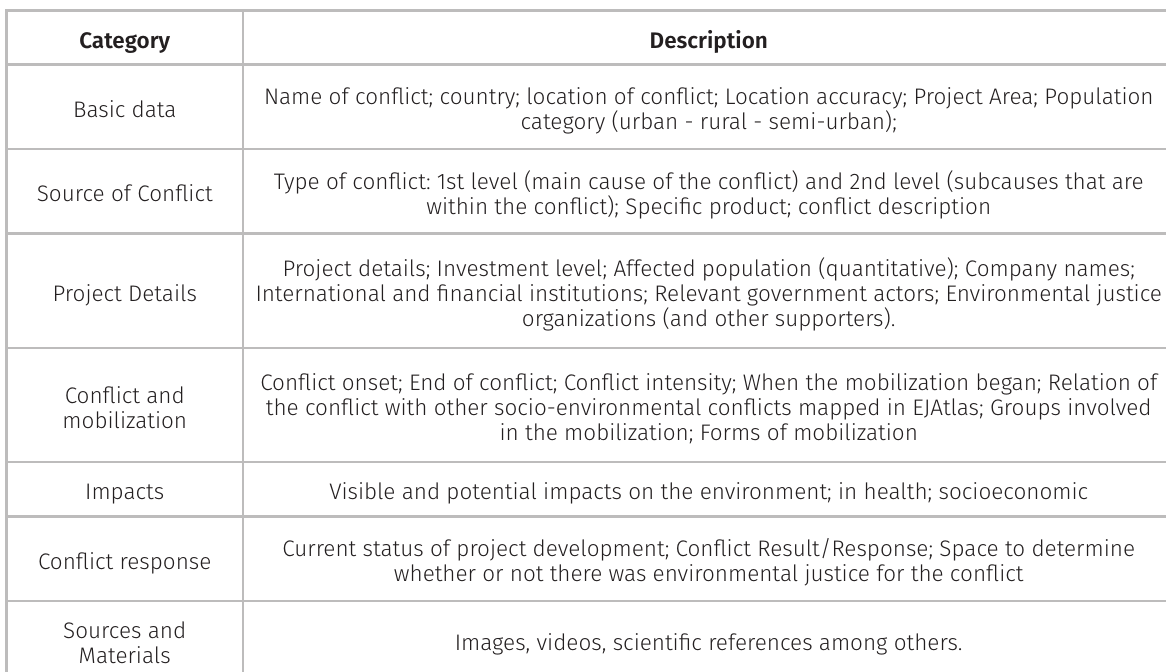
Table II. EJAtlas’ analysis categories for environmental conflicts. Category